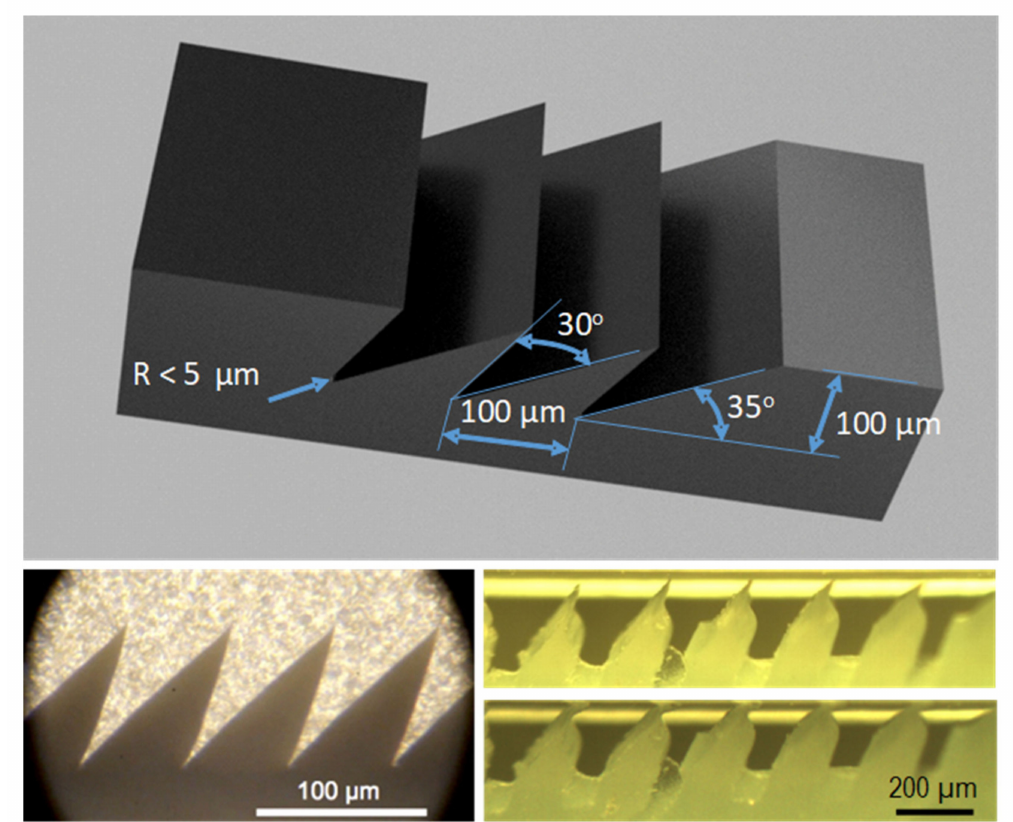
Figure 1. Geometrical specifications for the durable mold for gecko patches. Bottom left: micrograph of micromachined wax mold shapes (from [7] with permission from Mark Cutkosky, Stanford University). Bottom right: silicone gecko patch as cast (alternative hierarchical geometry from [8]) in unloaded and loaded conditions, showing the importance of the sharp tip for directional adhesion